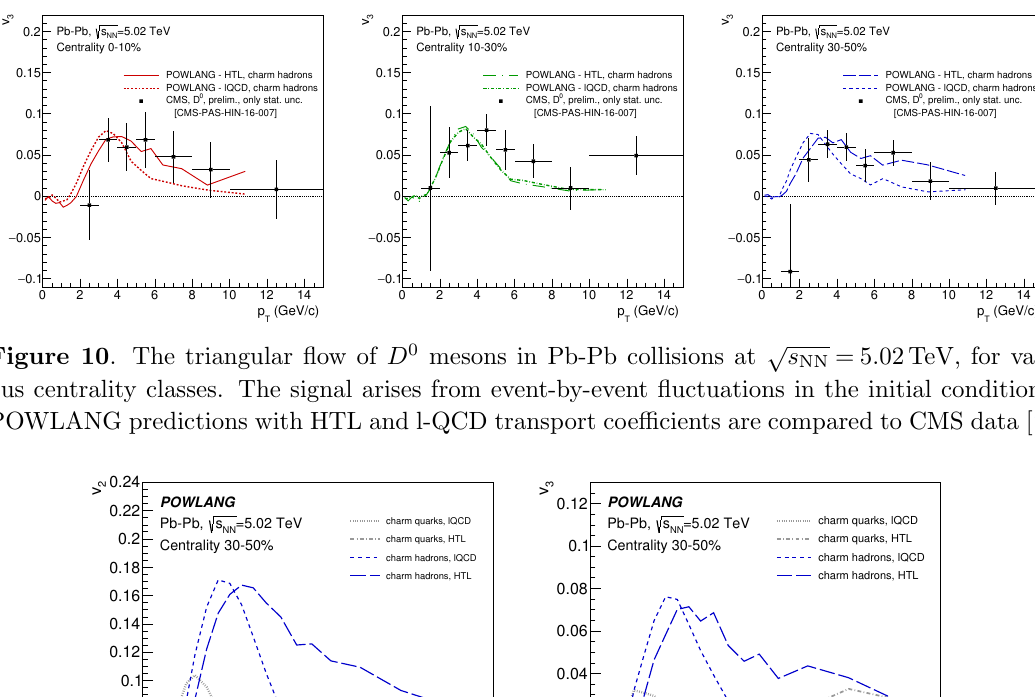
Figure 11 . The elliptic (left panel) and triangular (right panel) (cid:13)ow of charm quarks and hadrons p in Pb-Pb collisions at s NN = 5 : 02 TeV. The additional (cid:13)ow inherited at hadronization through recombination with light partons from the medium provides a signi(cid:12)cant contribution to the (cid:12)- nal